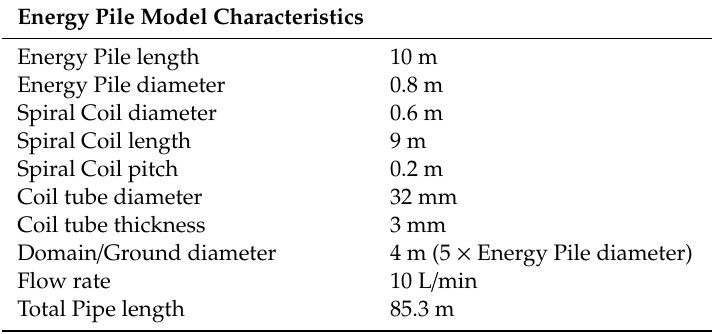
Table 3. Energy pile model dimensional characteristics and operating parameters.